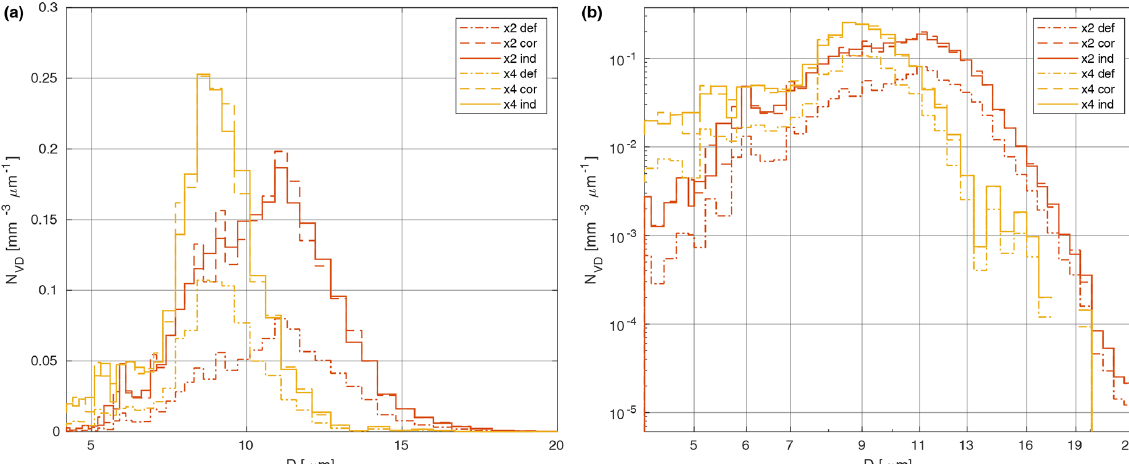
Figure 15. Droplet size distributions in clouds observed with the VisiSize D30 at Schneefernerhaus Observatory during two events on 13 July 2019: one in the afternoon (14:46–15:01LT) and the other in the late evening (23:19–23:34LT), the former taken with lens setting × 2 and the latter with setting × 4. Three methods of calculating the results – default (def), corrected (cor) and individual (ind) (see Sect. 3.4 for explanations) – are indicated by different line styles. The same data are plotted on (a) linear and (b) logarithmic scales. Table 6. Results of the cloud observations performed with the VisiSize D30 at Schneefernerhaus on 13 July 2019. Time (lens setting) 14:46–15:01LT (mag. × 2) 23:19–23:34LT (mag. × 4) Method